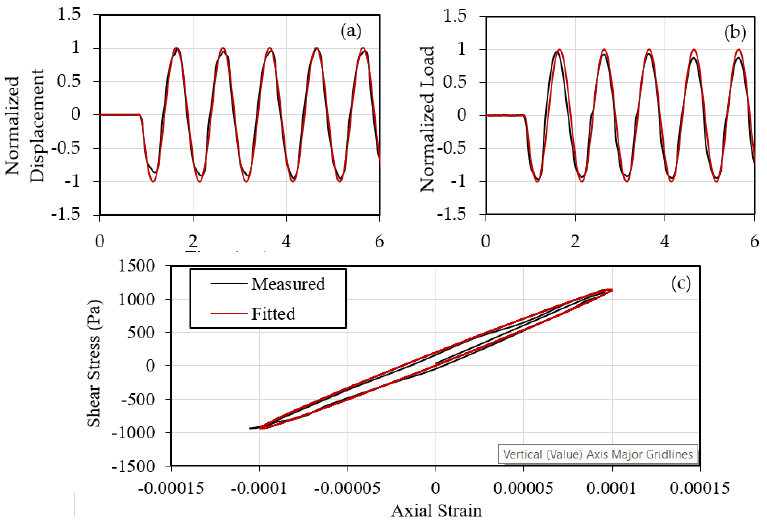
Figure 3. Typical measured and fitted functions for ( a ) displacement amplitude, ( b ) load amplitude, and ( c ) hysteresis loops (100 kPa).